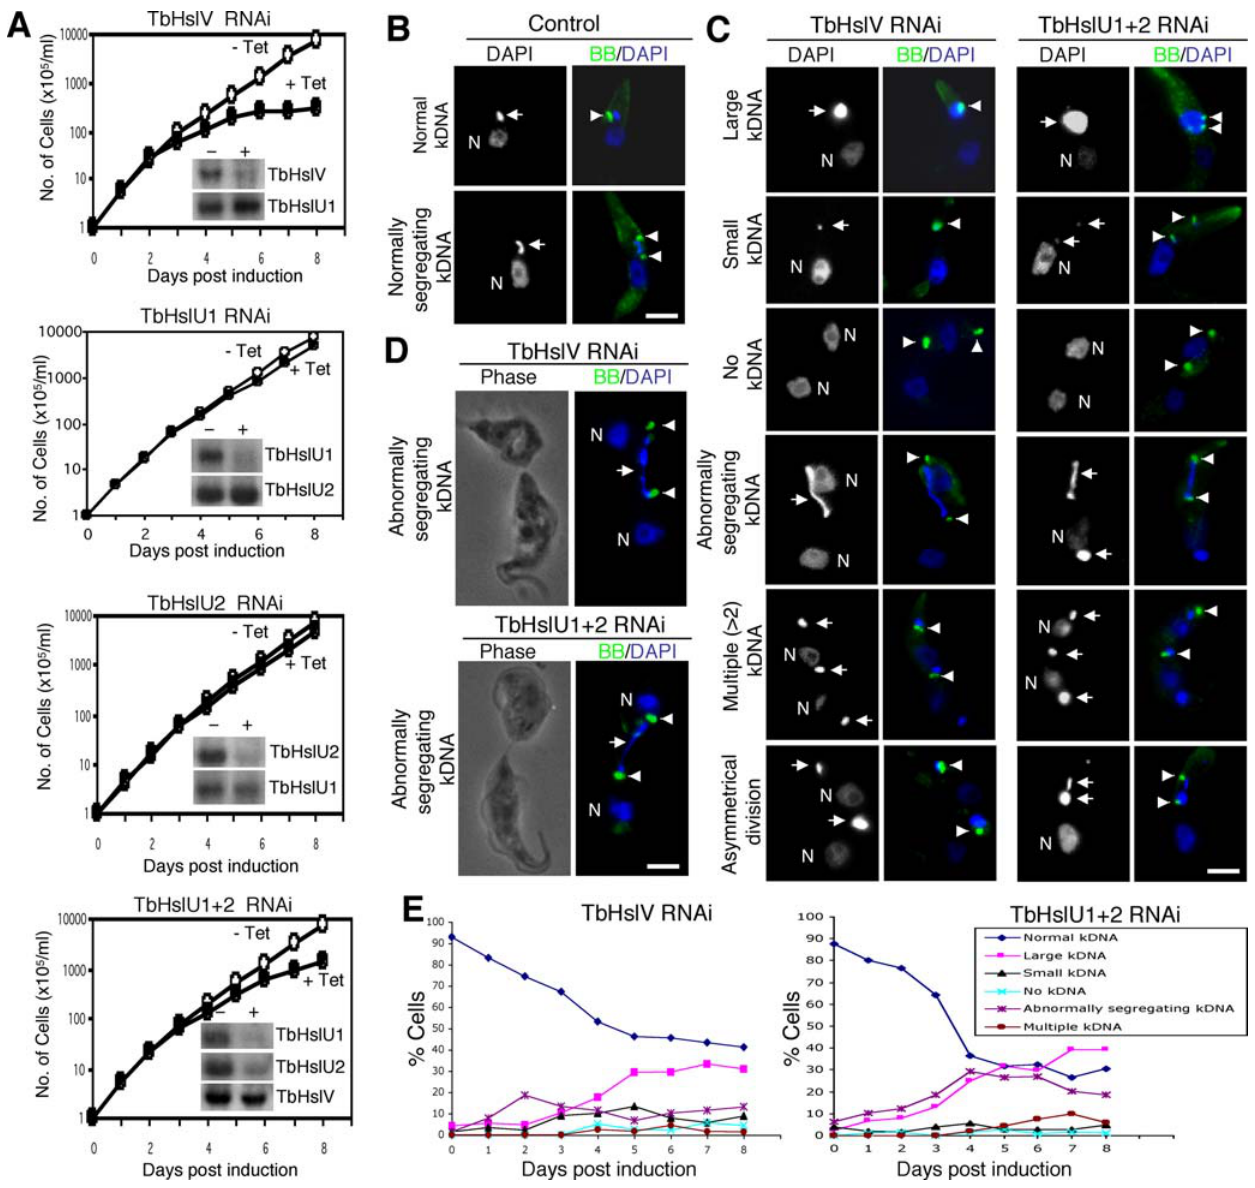
Figure 2. RNAi knockdown of TbHslVU affects cell growth and kinetoplast morphology. ( A ). Cells were grown in the presence ( + ) of tetracycline to induce RNAi for 7 days, and cell growth was monitored daily. Northern blots were performed to assess levels of TbHslV, TbHslU1 and TbHslU2 mRNA before ( 2 ) and after ( + ) 2 days of RNAi (insets). ( B–E ). Un-induced control cells ( B ) and cells after RNAi induction for 7 days ( C ) were labeled with YL1/2 antibody for basal bodies ( BB , arrowheads) and counterstained with DAPI for nucleus (N) and kinetoplast (arrows). ( D ). Two TbHslVU RNAi cells at the final stage of cell division were still connected by a thin thread of kinetoplast DNA (arrows) between two basal bodies (arrowheads) in two well-separated cells. Bars: 2 m m. ( E ). Tabulation of RNAi cells with kinetoplasts in varying sizes and morphologies. Approximately 200 cells were counted at each time point and the data represent averages from three independent experiments.